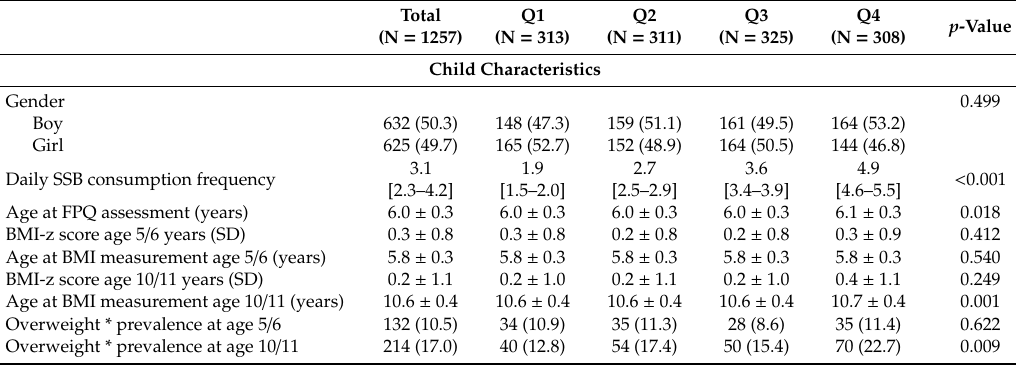
Table 1. Baseline characteristics of total study population and across quartiles of sugar-sweetened beverage (SSB) consumption